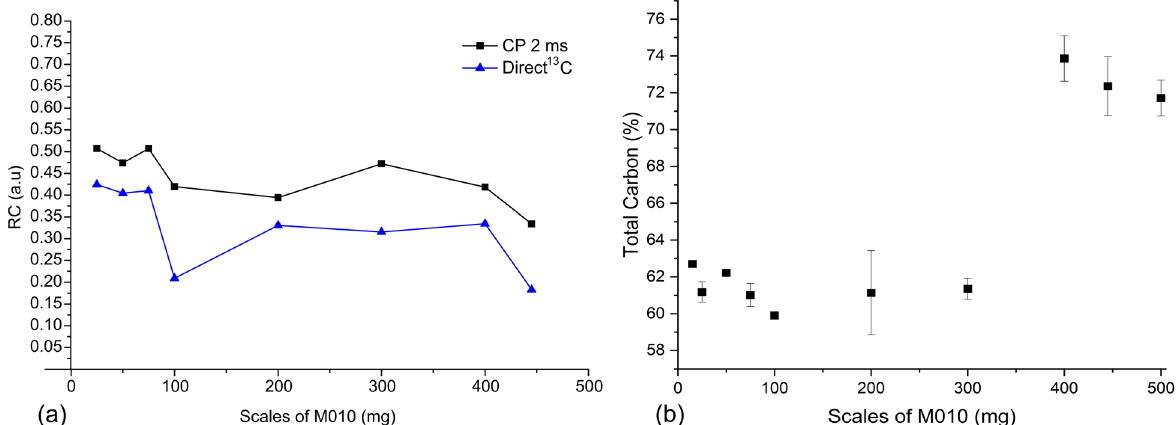
Fig. 6 Biochar derived from M010 at different mass scales (mg) showing a) the relative observable carbon (RC) in arbitrary units (a.u) and b) total carbon content